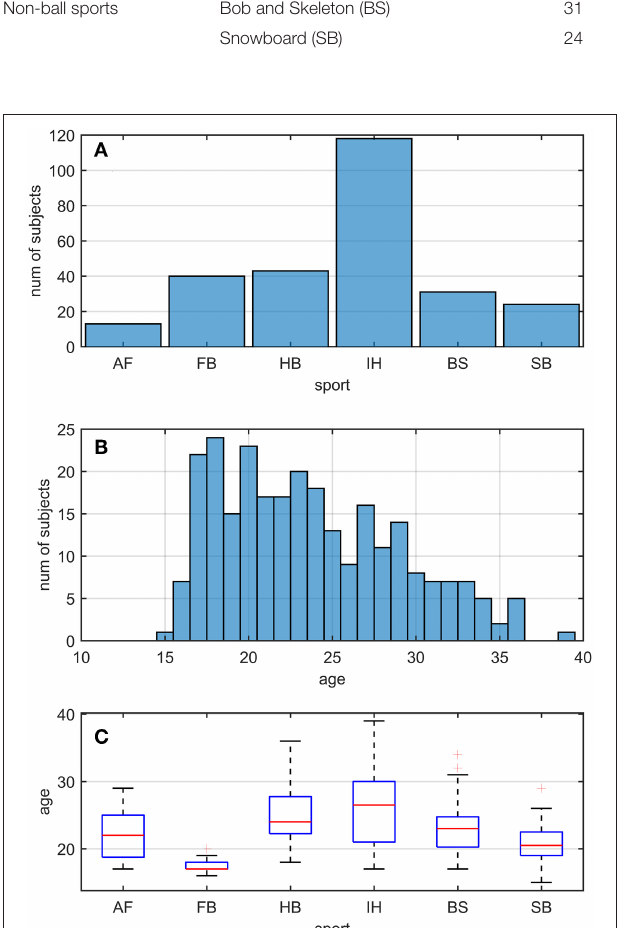
FIGURE 1 | Sport and age distributions of athletes. AF, American Football; FB, Football; HB, Handball; IH, Ice Hockey; BS, Bob and Skeleton; SB, Snowboard. (A) Number of athletes divided by sport. (B) Age distribution in the athletes. As visible, for each bin of one y.o. (expect for 15, 35, and 39), our data counted at least five athletes. (C) Boxplots of age distribution per sports. Despite sport groups did not cover overlapping age ranges, no relationship between and test performance was found (see Pooled Bin Approach: Between Sports Analysis in Results).